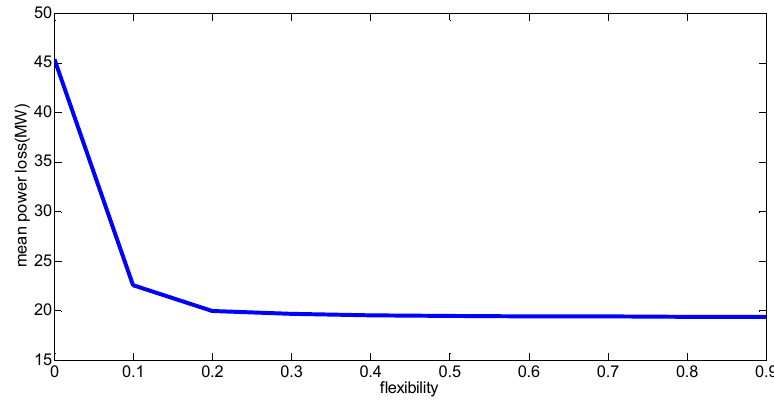
Figure 5. The impact of different flexibility values.